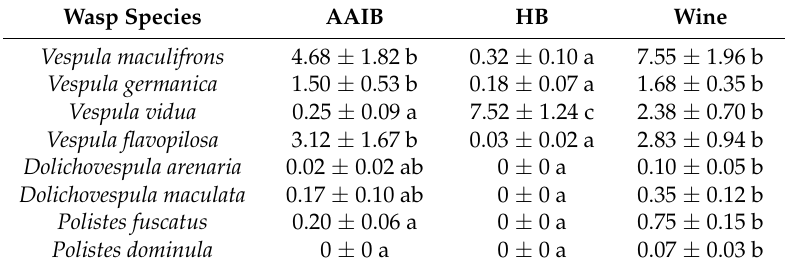
Table 1. Mean ± SEM number of social wasps captured per trap per week baited with acetic acid and isobutanol (AAIB), heptyl butyrate (HB), or wine from 21 July through 22 September 2015 in South Central Wisconsin vineyards.